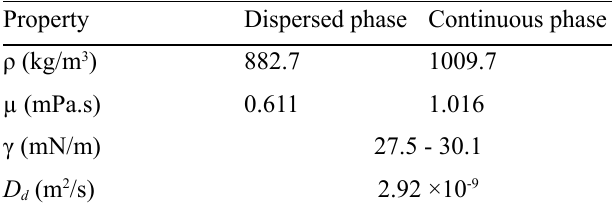
Table 1. Physical properties of chemical materials at 20 o C [17].